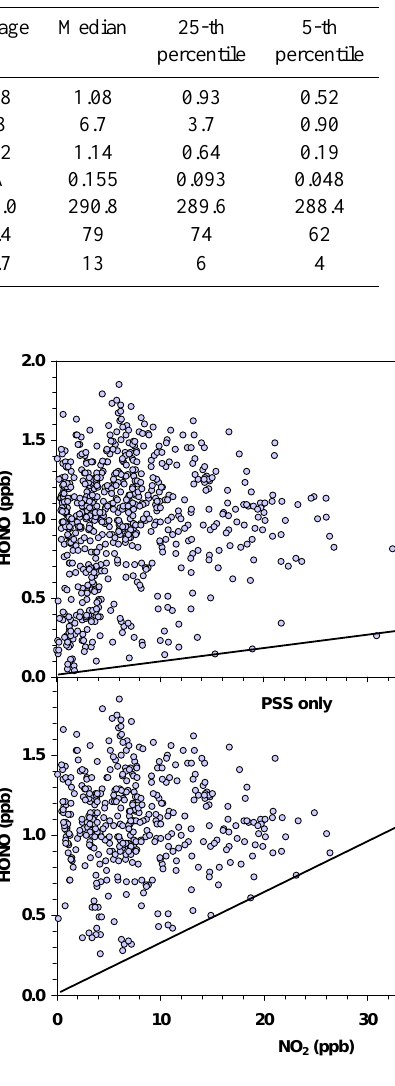
Fig. 5. Relationship between HONO and NO 2 using (a) all data. The lower limit line indicates HONO/NO 2 = 0.0084, fuel combus- tion sources (b) only data during the PSS period (10:00p.m.– Figure 5. Relationship between HONO and NO 2 using a) all data. The lower limit line 05:00a.m.): the lower limit line indicates HONO/NO 2 =0.033. See indicates HONO/NO 2 = 0.0084, fuel combustion sources b) only data during the PSS period text for (10:00 pm - 5:00 am): the lower limit line indicates HONO/NO 2 = 0.033. See text for details.